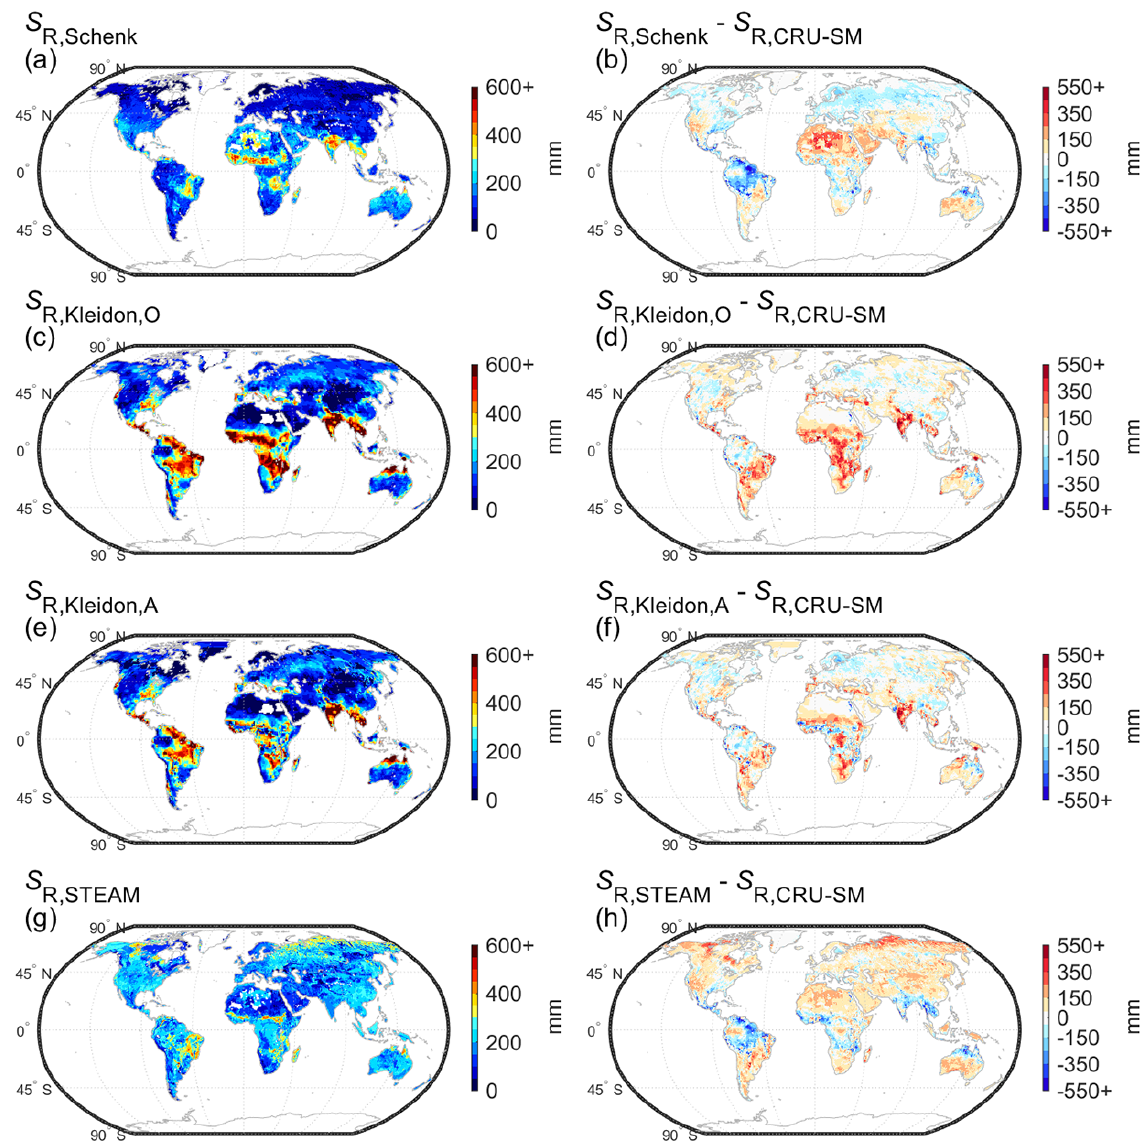
Figure 4. Root zone storage capacities of (a) S R,Schenk (Schenk and Jackson, 2009), (c) S R,Kleidon,O (Kleidon, 2004), (e) S R,Kleidon,A (Kleidon, 2004), (g) S R,STEAM (based on look-up table in Wang-Erlandsson et al. (2014)) and (b, d, f, h) their differences with S R,CRU-SM (estimated based on E SM and P CRU in this study). Values below 0.5% of the maximum in (a) , (c) , (e) , and (g) are displayed as